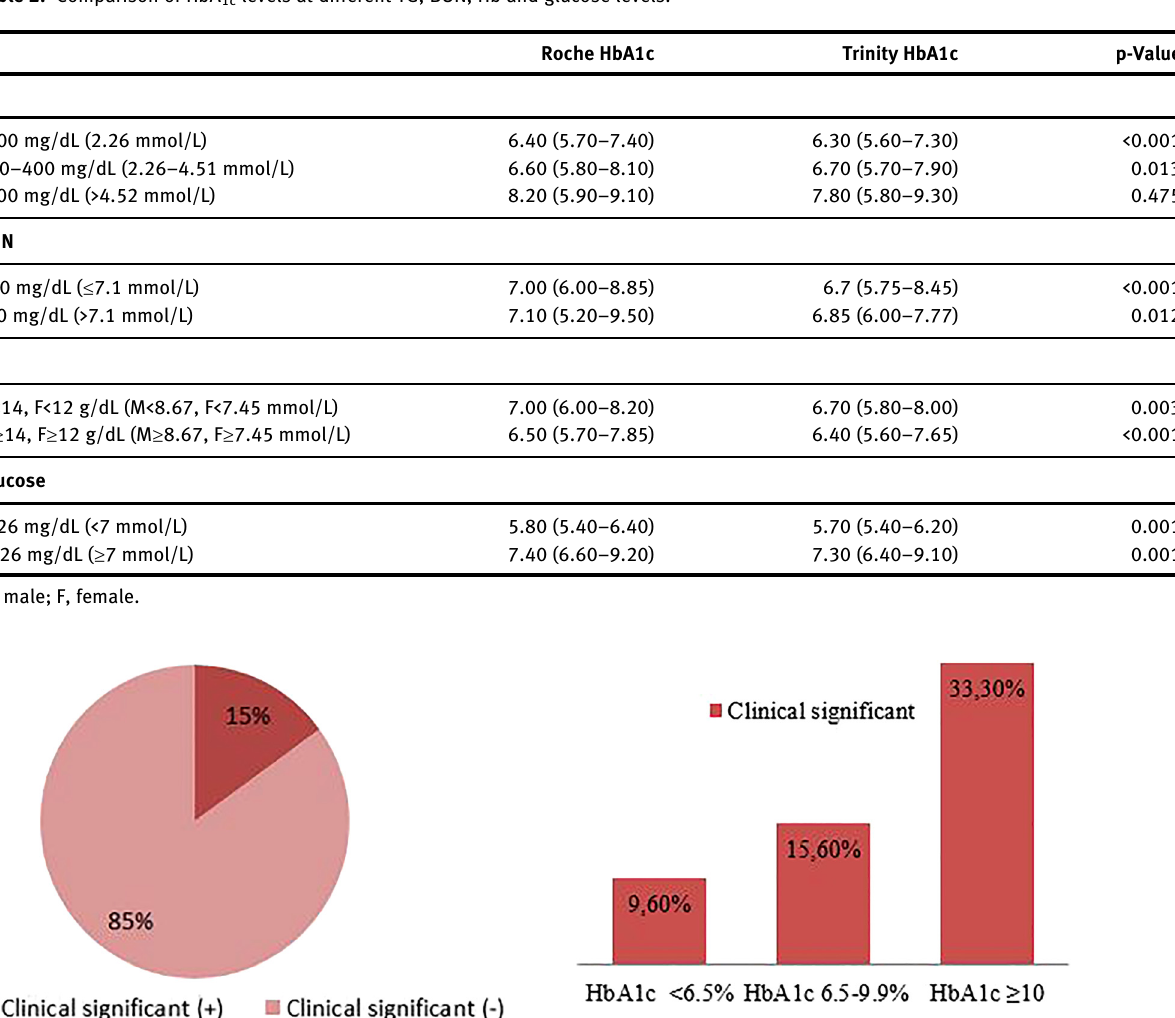
Table  : Comparison of HbA  c levels at different TG, BUN, Hb and glucose levels.